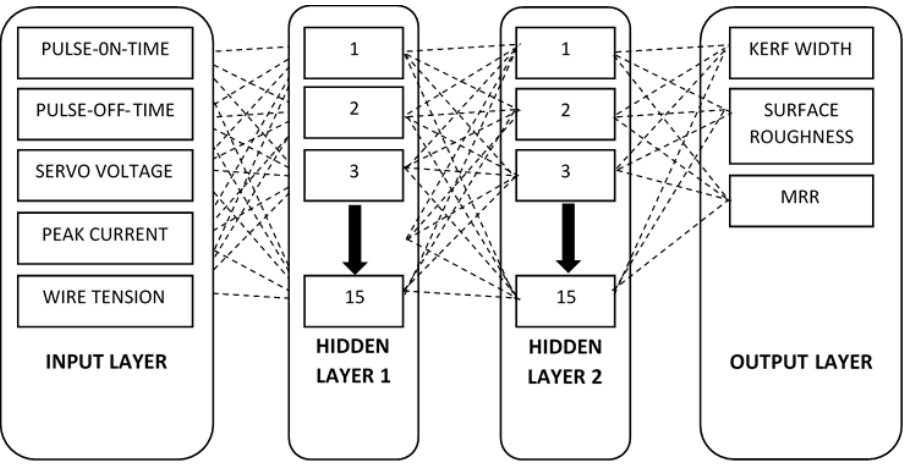
Figure 3. Artificial Neural Network architecture (5-N 1 -N 2 -3).